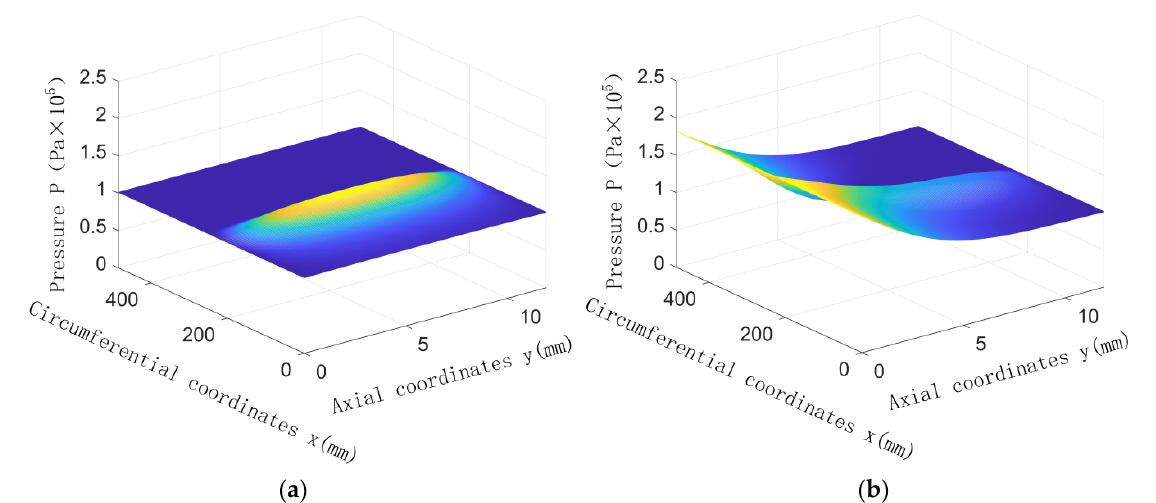
Figure 7. Mode 3 (counter-rotation): ( a ) without inlet pressure difference; ( b ) with inlet pressure difference.